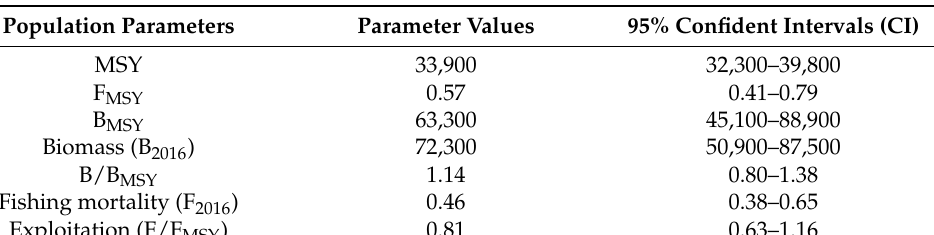
Table 3. Estimated r, k , and MSY of croaker in the BoB, with 95% confident intervals (CI).